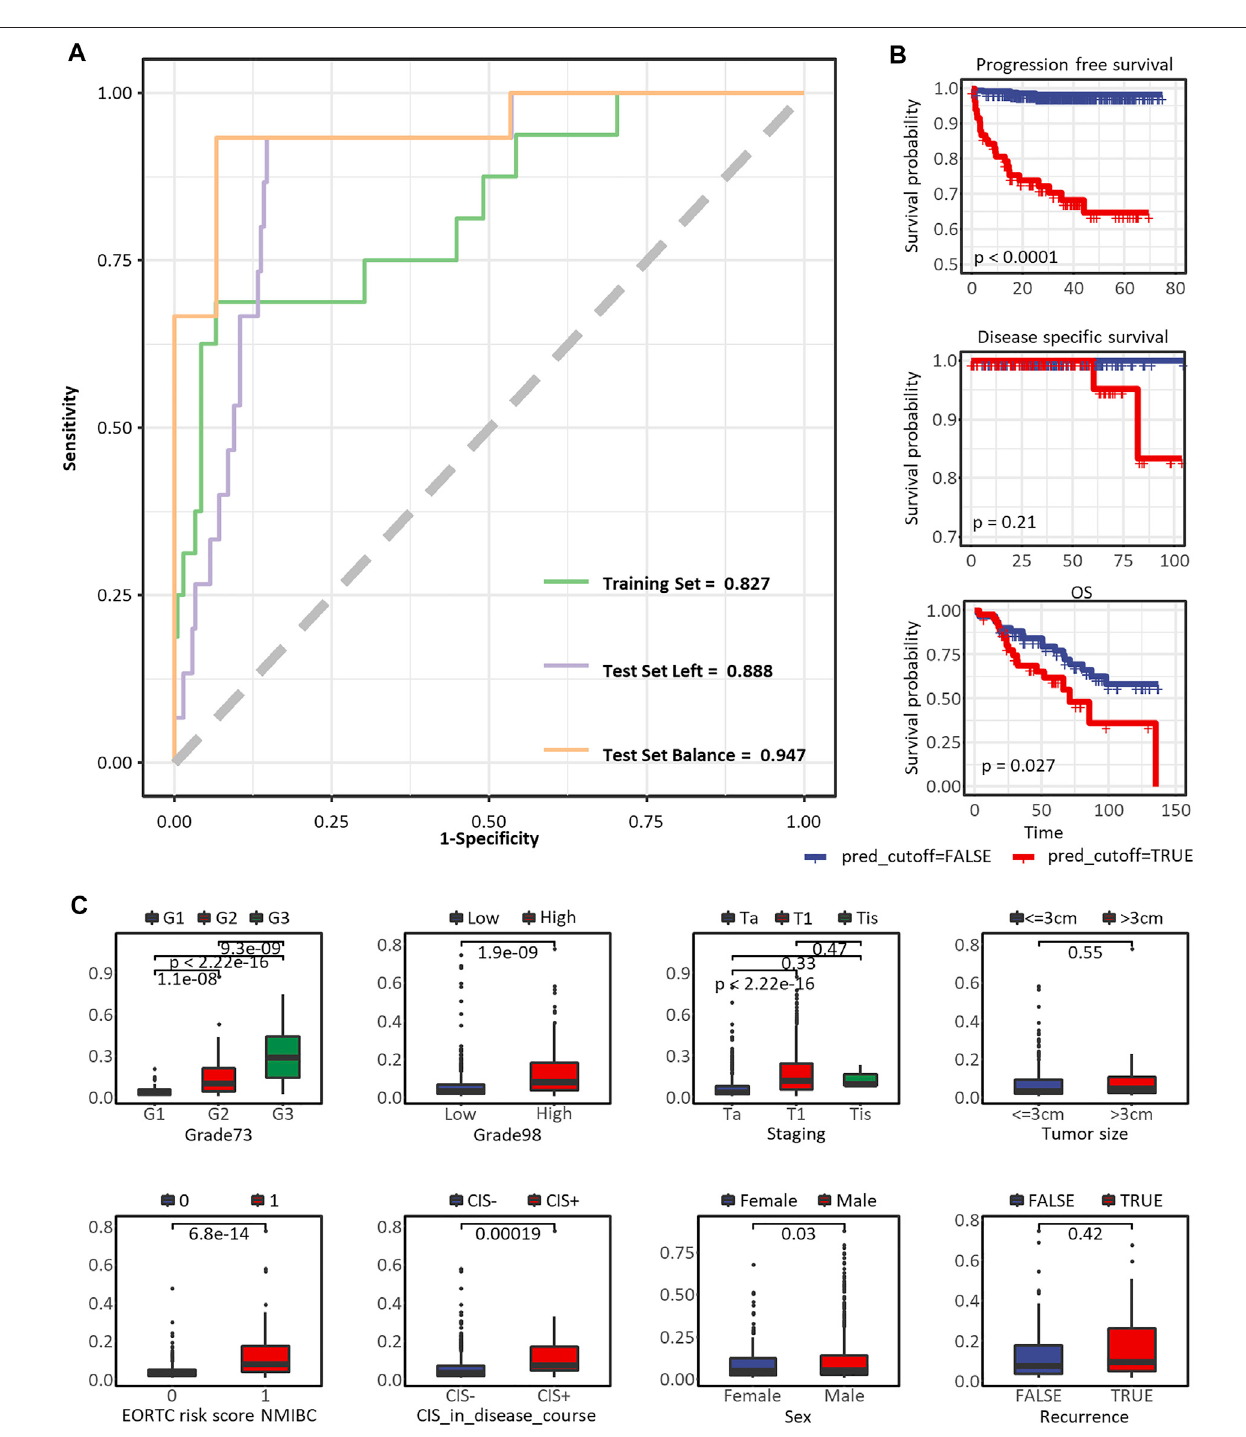
FIGURE 5 | Predictive performance of the immuno-prognostic model. (A) The ROC curve to predict PFS in the training set, test set with all the other samples, and test set with balanced progressed and non-progressed samples. (B) The Kaplan-Meier curve to predict PFS, DFS, and OS*. (C) Box plots comparing risk scores assessed by the immuno-prognostic model in different groups of clinical prognostic risk factors. * In the nine eligible datasets, PFS status was assessed in E-MTAB- 4321, GSE13507, and GSE32894, while only E-MTAB-4321 provided survival time. DFS status was assessed in GSE32894, GSE13507, and GSE48075, while only GSE32894 provided survivaltime. OSstatus was assessed in GSE13507 and E-MTAB-1940, while only GSE13507 provided survival time.Asweplotted here, the survival analyses were only applicable to datasets E-MTAB-4321, GSE32894, and GSE13507.